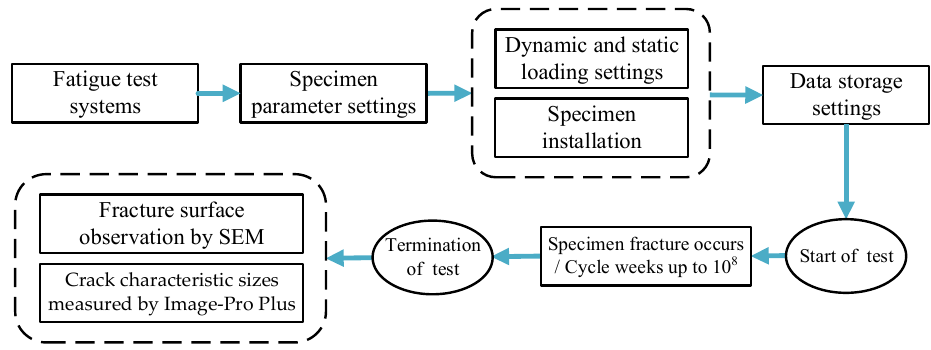
Figure 4. The flow chart of fatigue test.